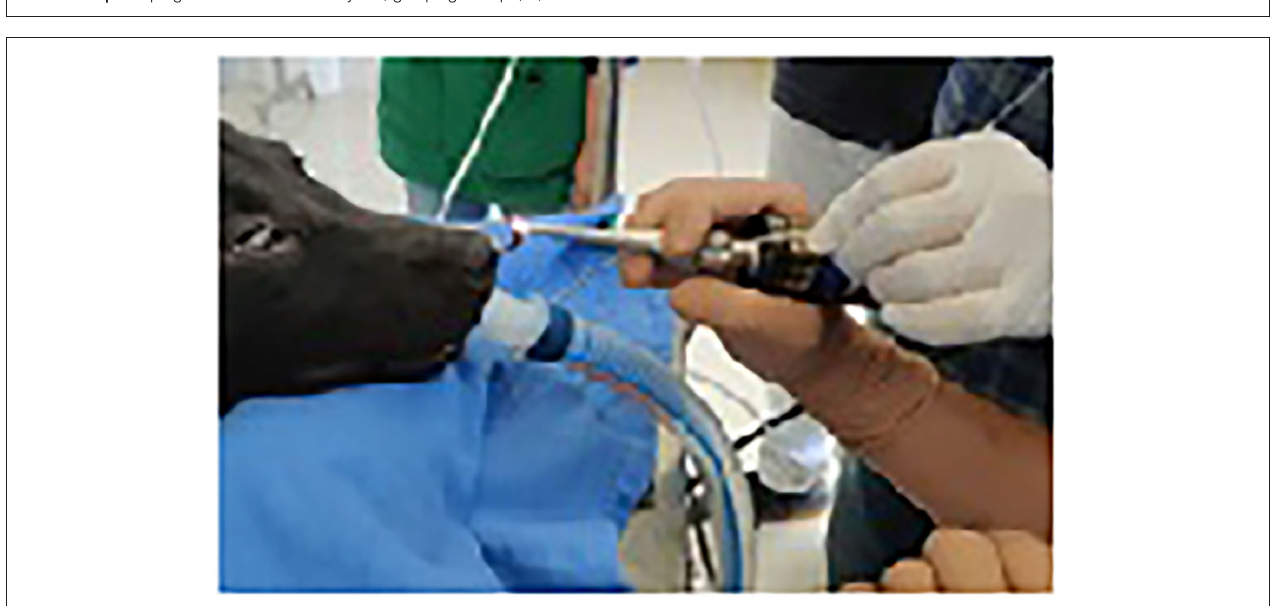
FIGURE 4 | Retrieved nasal leech. RL, retrieved leech; VO, video-otoscope.